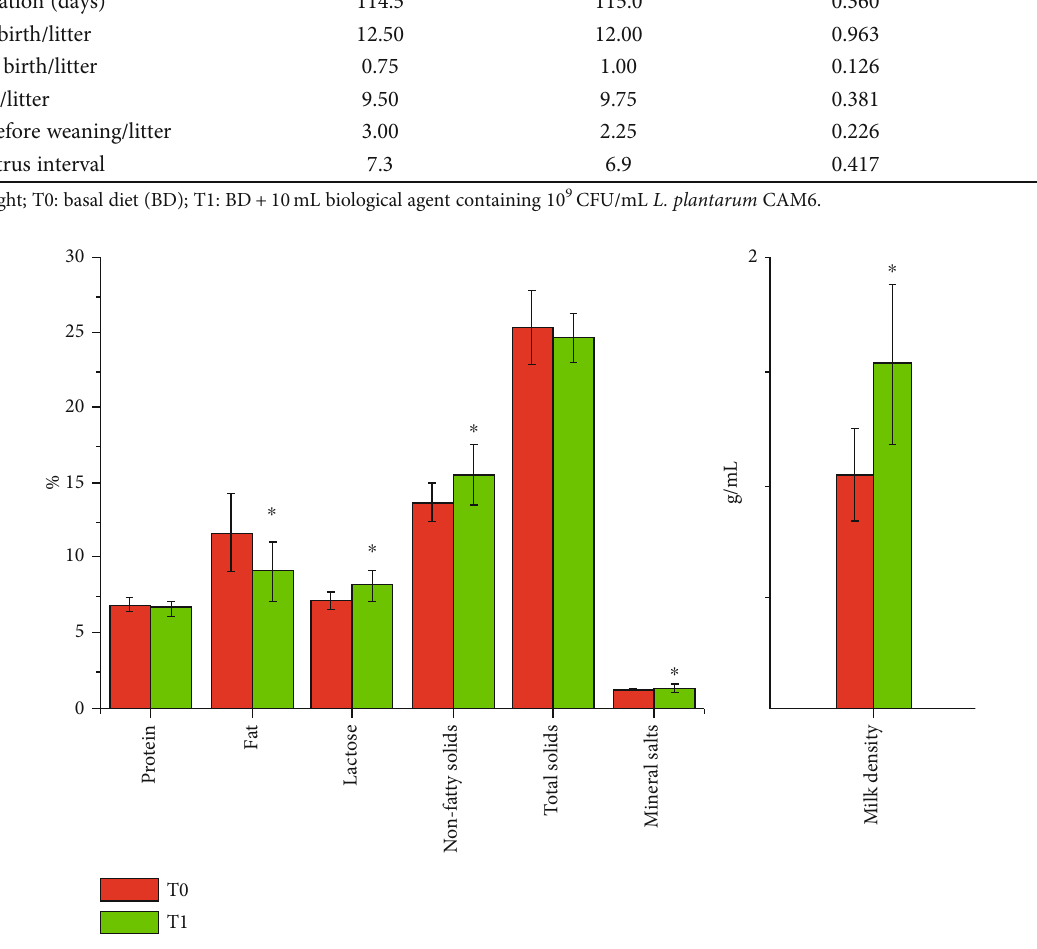
Figure 1: E ff ect of the oral administration of Lactobacillus plantarum CAM6 for sows on the chemical composition and density of milk produced by them. T0: basal diet (BD); T1: BD + 10 mL biological agent containing 10 9 CFU/mL L. plantarum CAM6. ∗ P ≦ 0 : 05